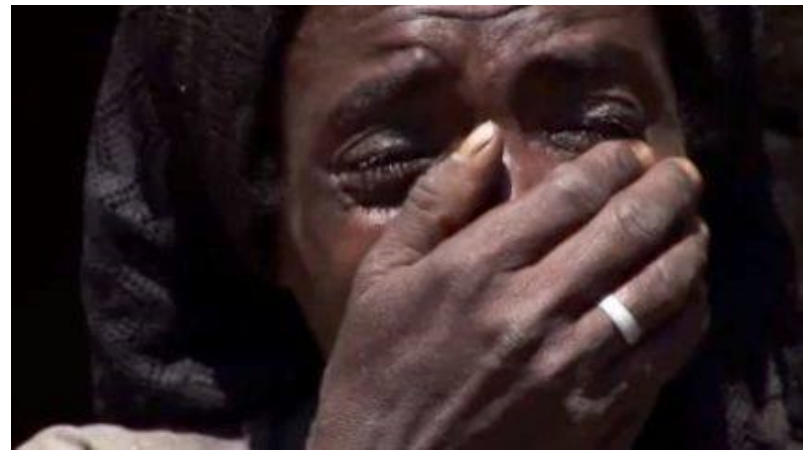
Figure 8. Amina. Courtesy of Aljazeera BBC, “People and Power” program (21 February 2009). [Text